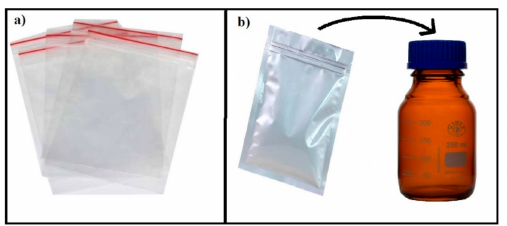
Figure 10. Packaging of paracetamol instant jelly: ( a ) packaging 1 and ( b ) packaging